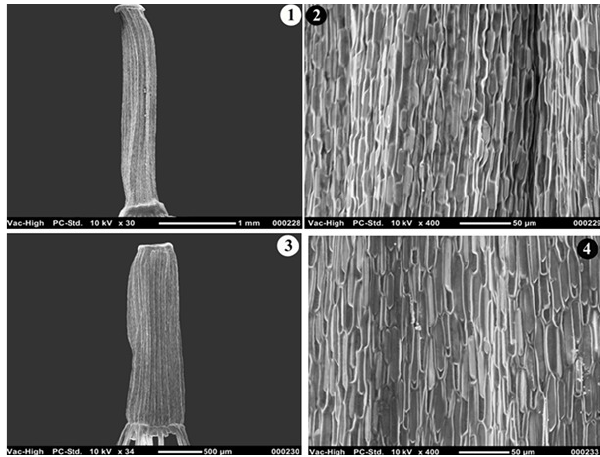
Fig. 5. Scanning electron micrographs (SEM) of cypsela of Inula species.1. General view of cypsela of I. helenium